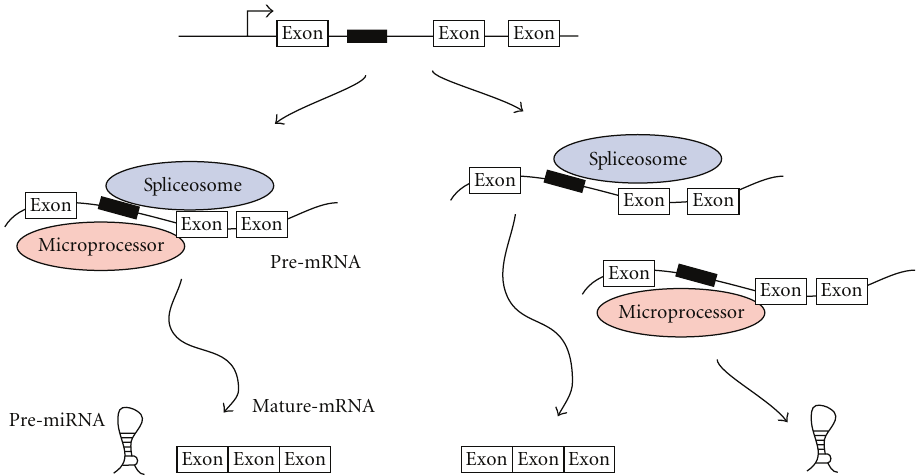
Figure 2: Possible models for intronic miRNA biogenesis. Either both miRNA and mRNA are generated from one RNA transcript (left scheme), or each is generated from an individual transcript (right